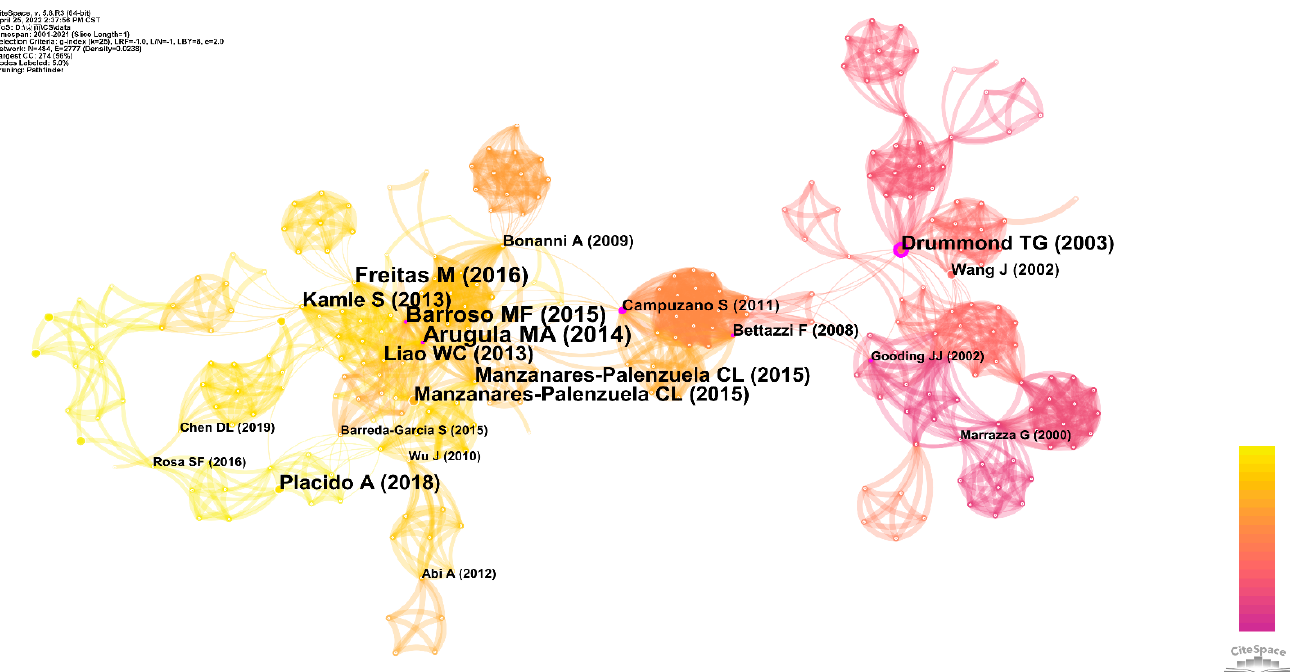
Figure 10. Co-citation analysis for electrochemical techniques for the detection and analysis of GM crops.